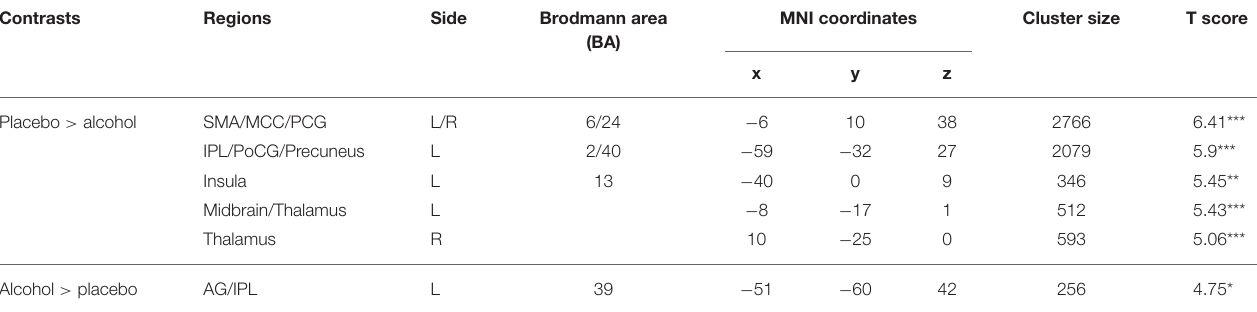
TABLE 4 | Main effects of